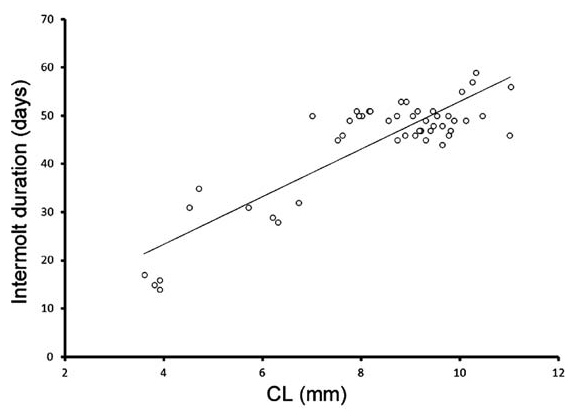
Fig. 4. – Intermoult duration in young of the year of Munida gre- garia in laboratory cultures.